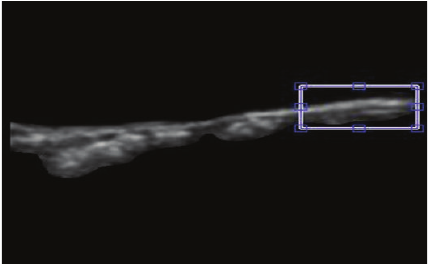
Figure 4: Manual cropping of a region of interest (ROI) marked by a rectangle.